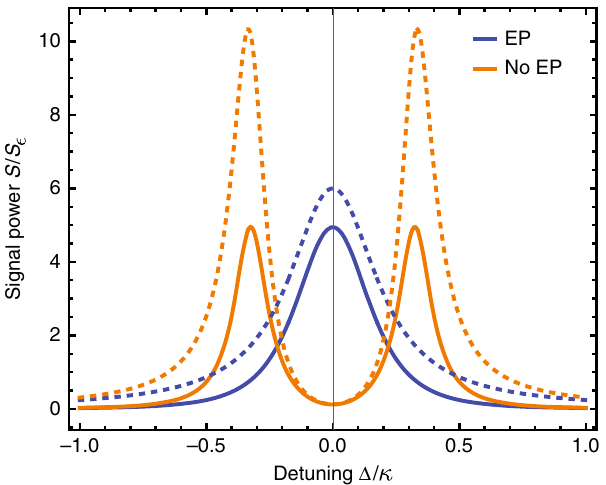
Fig. 3 Signal power versus drive detuning for two reciprocal two-mode sensors. An EP system (blue, described by Eq. (31) with κ + γ 1 = κ , γ 2 = − 0.3 κ , J = 0.325 κ ), and a simple two-mode ampli fi er system that never has an EP (orange, Eq. (31) with κ + γ 1 = γ 2 = 0.16 κ , J = 0.325 κ ). The two systems have similar peak signal powers. Dotted lines denote bound on signal power for both systems as given by Eq. (29)